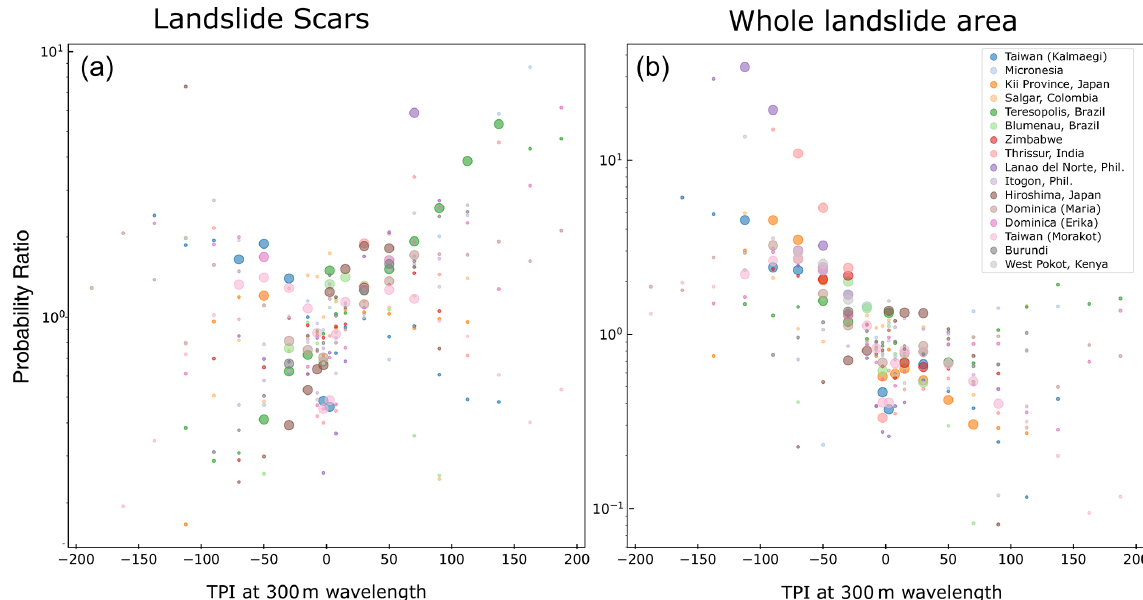
Figure 9. Same as Fig. 4 but for the topographic position index (however, here we omit normalization given that the TPI is a zero-centered variable) with an analysis window radius of